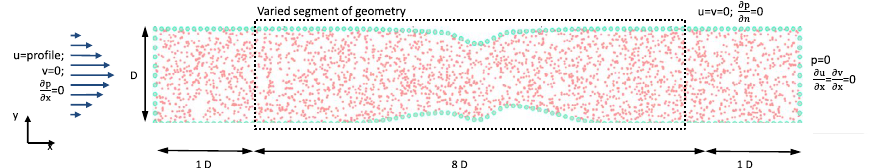
Fig. 3 Schematic of irregular geometric vessel with a fixed set of boundary and fluid domain points. With Dirichlet and Neumann boundary conditions: parabolic velocity profile at the inlet, zero velocity at walls and zero pressure at the outlet as well as zero gradient in reference to normal vectors ( n ) of geometry for pressure on inlet and vessel walls and velocity at the outlet. Red points are indicating internal points and green points are indicating points on the